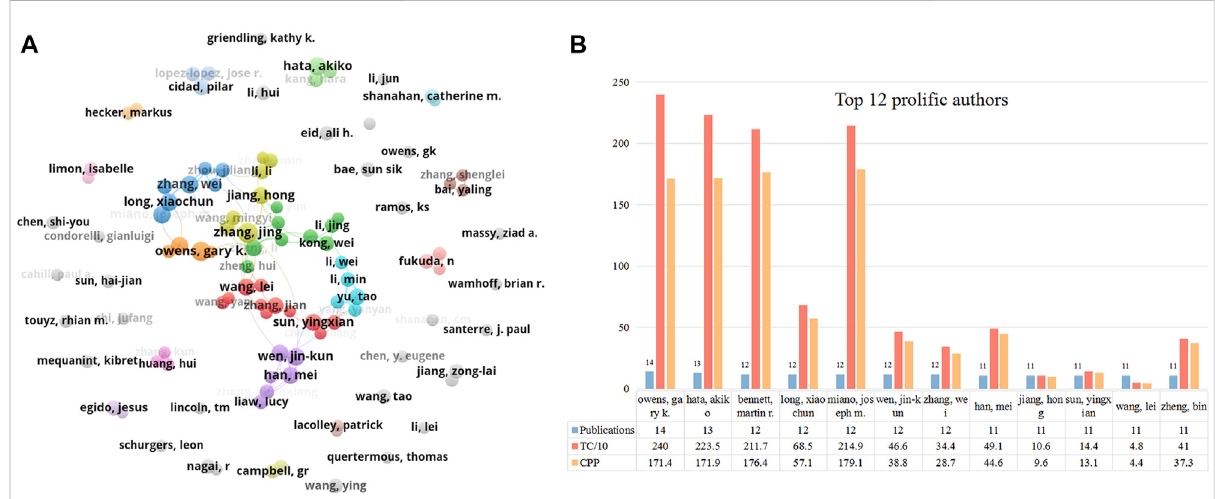
FIGURE 5 The top 12 most productive authors and collaboration network centered around these authors. (A) Collaboration among proli fi c authors who publishedmorethan6papers.Nodesizere fl ectsthenumberofpublications.Thewidthoflinksrepresentsthecooperativestrength. (B) Thenumber of publications, total citations (TC), and citations per publication (CPP) in the top 12 proli fi c authors.